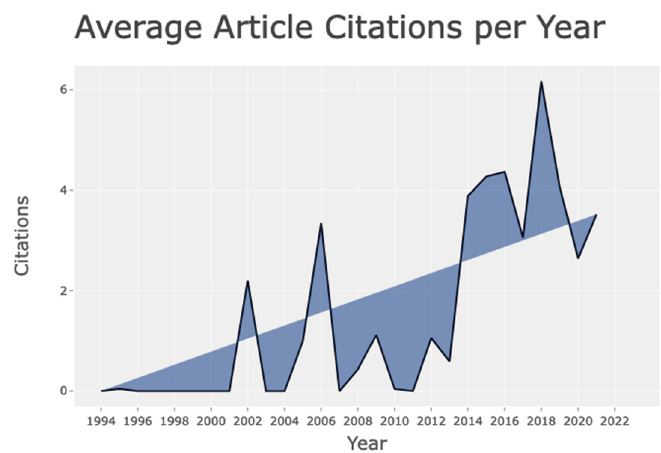
Figure 10. Citations trends, total and per year.